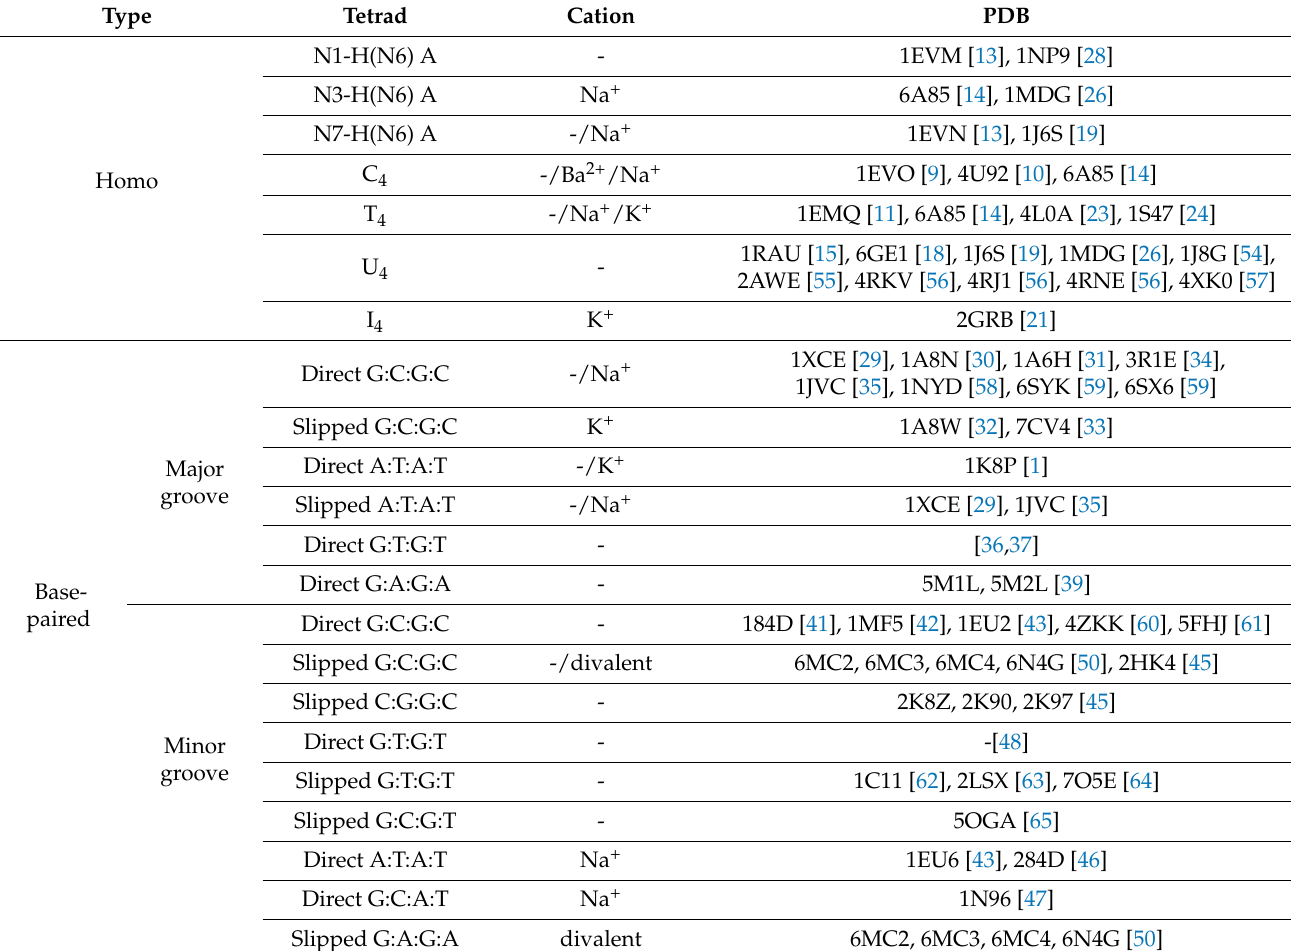
Table 1. Structures with the different non-G tetrads mentioned in the text with their corresponding references and their PDB codes, when